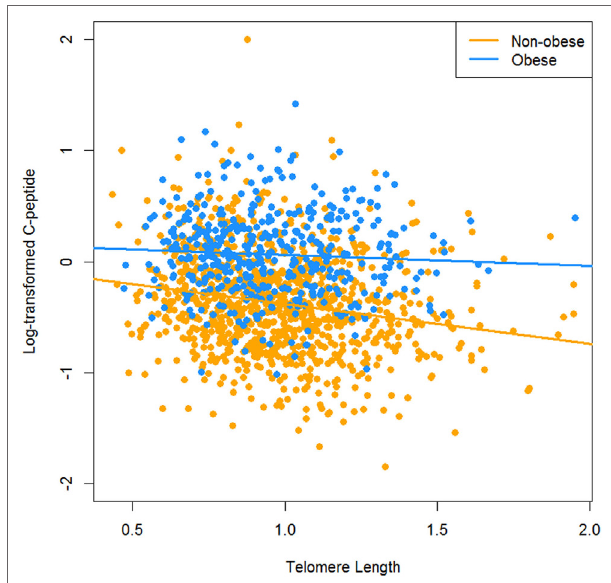
FigUre 2 | The relationship between C-peptide and telomere length by obesity.